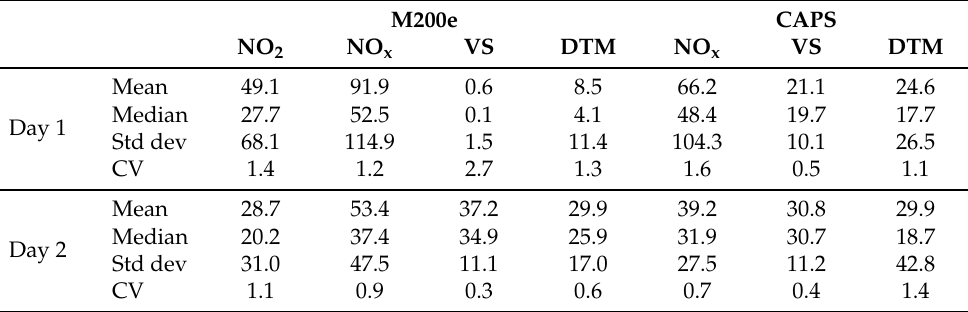
Table 3. Mean, median, standard deviation and Coefficient of Variance (CV) for the measured and modelled concentrations (µg/m 3 ). These values are total concentrations, no background subtraction has been applied to to these